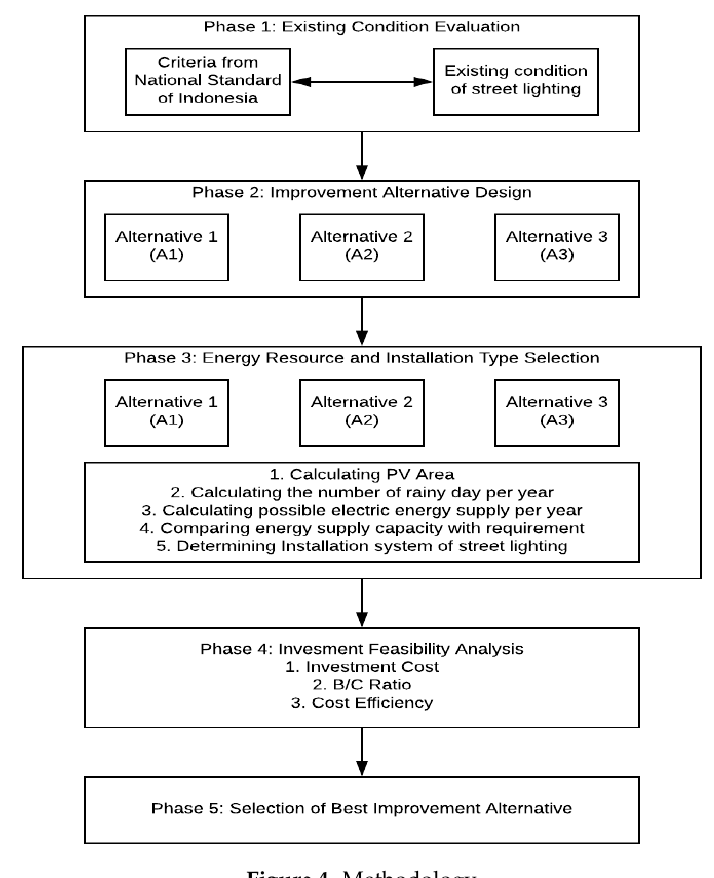
Figure 4. Figure 4. Methodology.